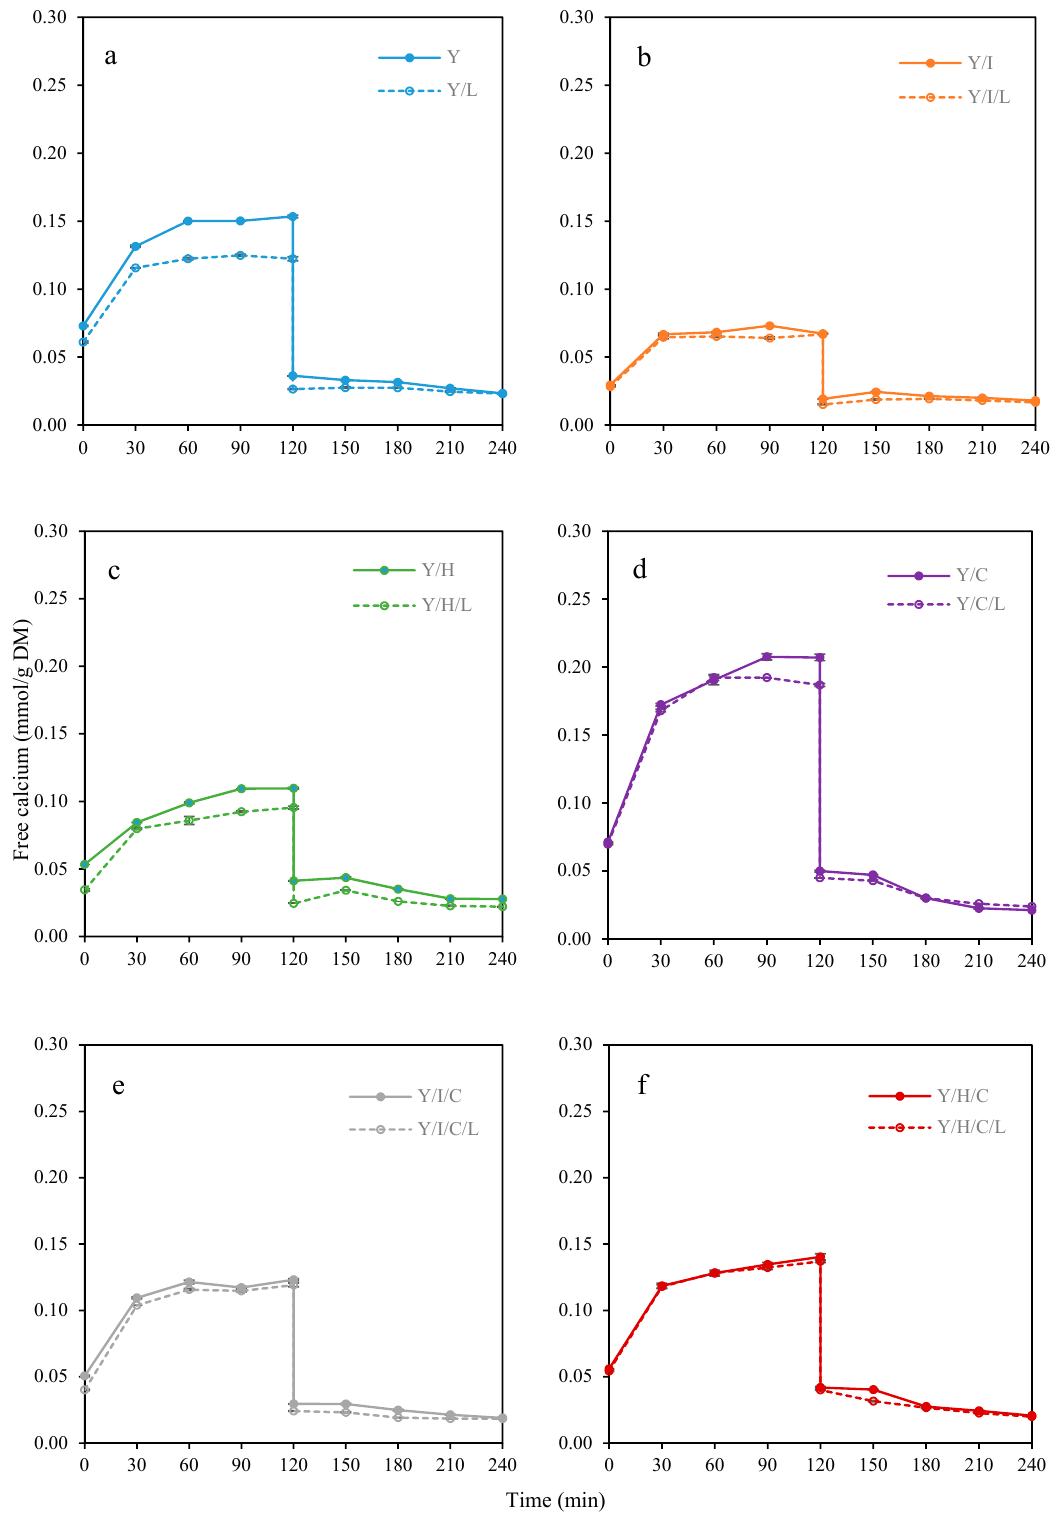
Figure 2. Free calcium changes per gram dry matter of snacks during in vitro digestion, including gastric phase at pH 3 (0–120 min) and intestinal phase at pH 7 (120–240 min). ( a ) Y and Y/L; ( b ) Y/I and Y/I/L; ( c ) Y/H and Y/H/L; ( d ) Y/C and Y/C/L; ( e ) Y/I/C and Y/I/C/L; ( f ) Y/H/C and Y/H/C/L.